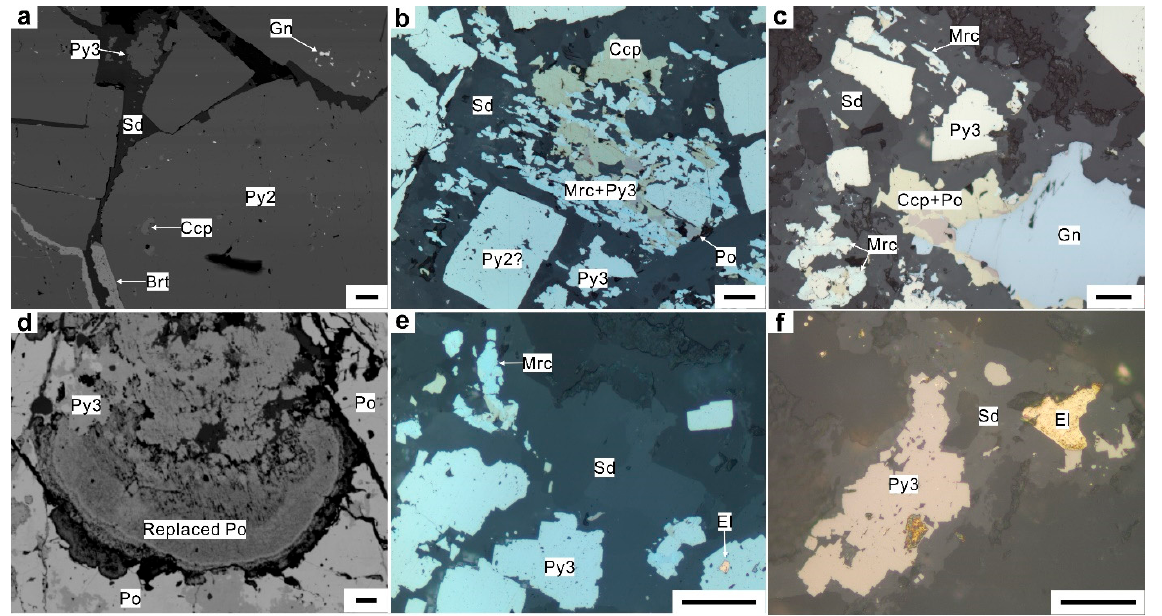
Figure 6. Reflected light ( b,c , e,f ) photomicrographs and BSE image ( a , d ) illustrating textures and mineral assemblages of Py3 in the Sizhuang gold deposit. ( a ) Fine-grained Py3, siderite, and barite filling into the fractures and interstice among euhedral Py2 crystals. ( b,c ) Typical mineral assemblage of Py3, marcasite, chalcopyrite, pyrrhotite, galena, and siderite in stage 3. Note marcasite formed slightly late than Py3, chalcopyrite, and pyrrhotite with respect to the replacement relationship. ( d ) Pyrrhotite locally or totally transformed as Py3 or colloform pyrite. ( e ) Electrum as inclusions within a Py3 grain. ( f ) Free electrum, Py3, and siderite of stage 3. Scale bar is 50 µm. Brt barite; Ccp chalcopyrite; El electrum; Gn galena; Mag magnetite; Mrc marcasite; Sd siderite; Po pyrrhotite; Py pyrite; Qz quartz.